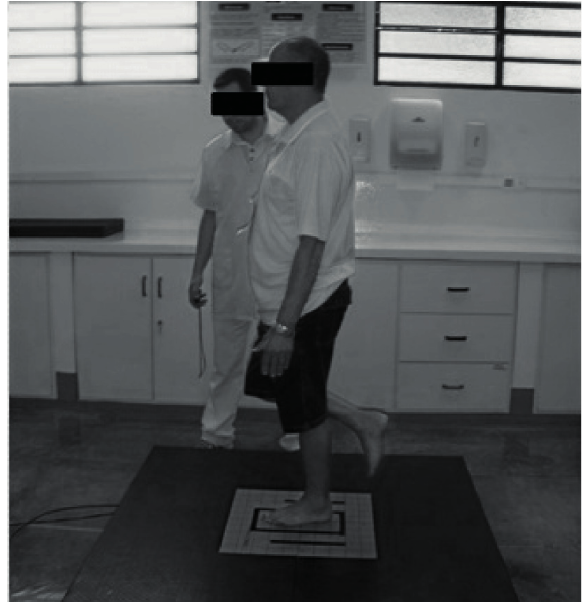
Figure 1 - Postural balance assessment in one-leg stance condition on the force